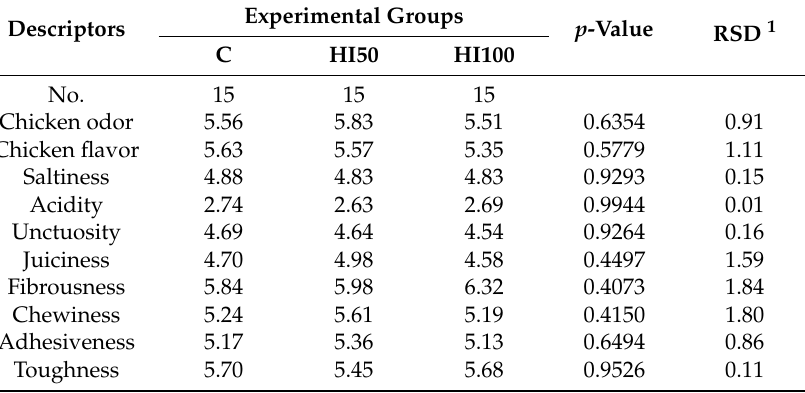
Table 7. Sensory traits of the breast meat of chickens fed with 0% (C), 50% (HI50) and 100% (HI100) substitution of soybean oil with Hermetia illucens (HI) larvae fat in their finisher